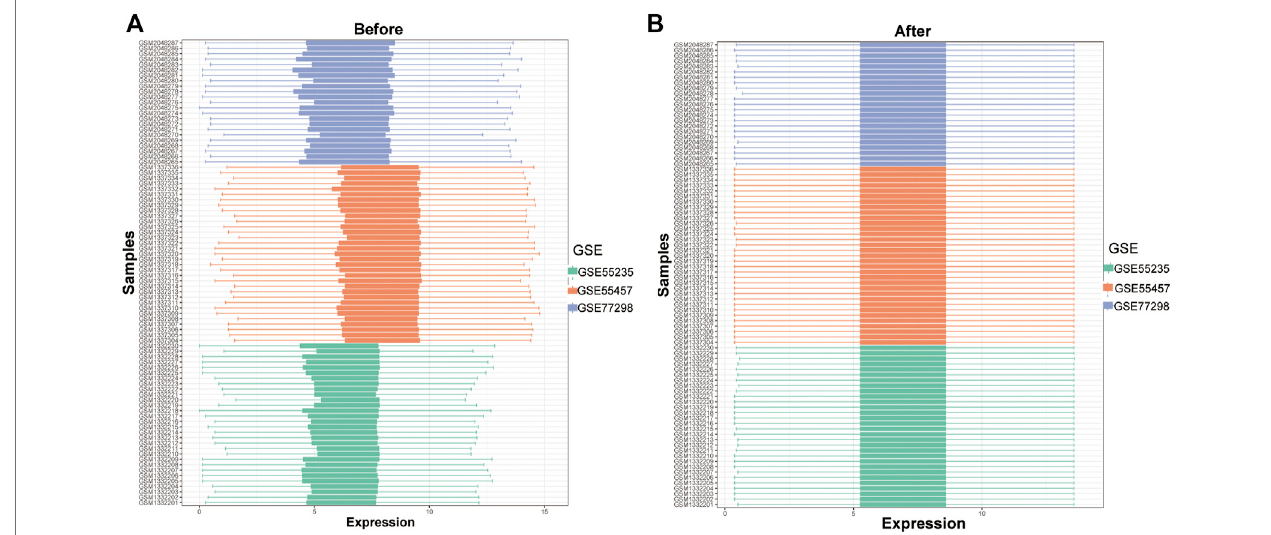
FIGURE 2 | Data integration of typhoon expression matrix. (A) : The overall gene expression values of the three GEO data sets before correction, (B) : The overall gene expression values of the three GEO data sets after correction.